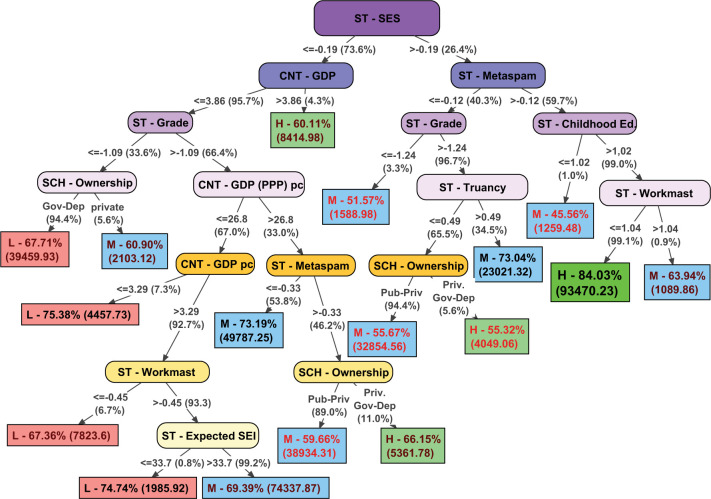
Final decision tree (J48).